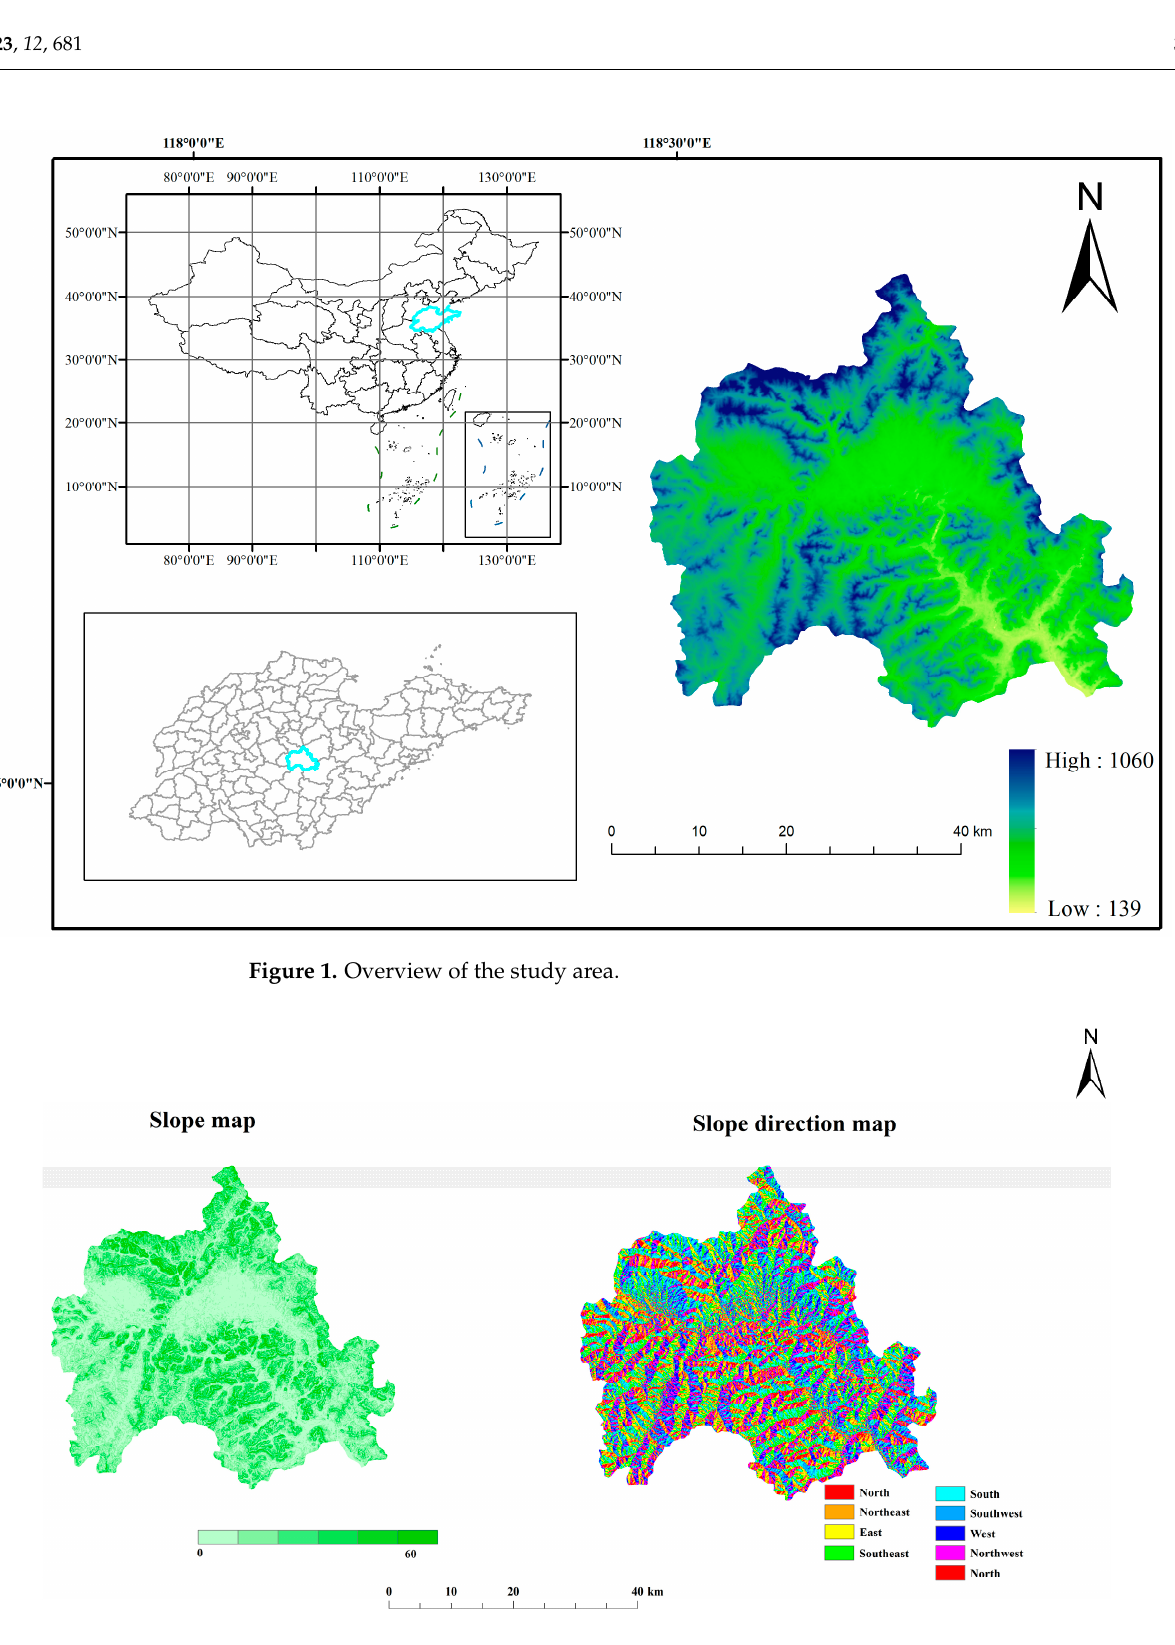
Figure 2. Slope orientation map of the study area. The blue part shows the topographic elevation distribution of the study